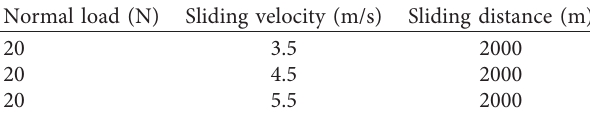
Table 3: Wear test conditions.